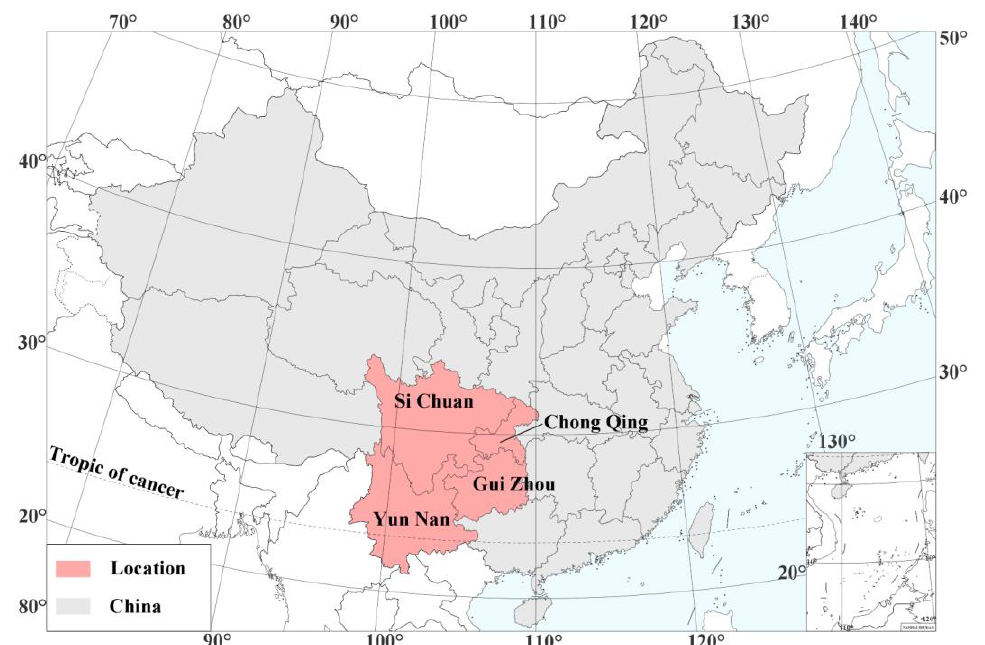
Figure 1. Location of chosen